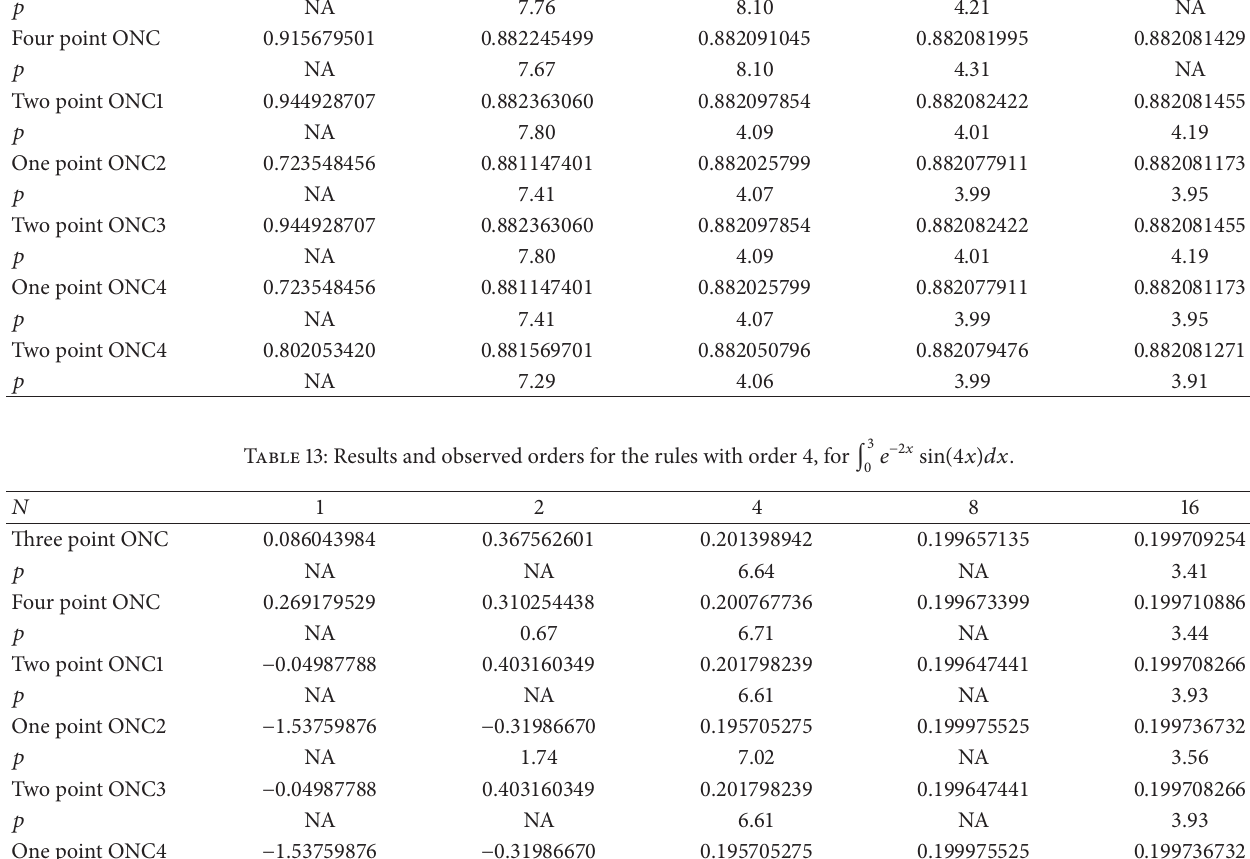
Table 12: Results and observed orders for the rules with order 4, for ∫